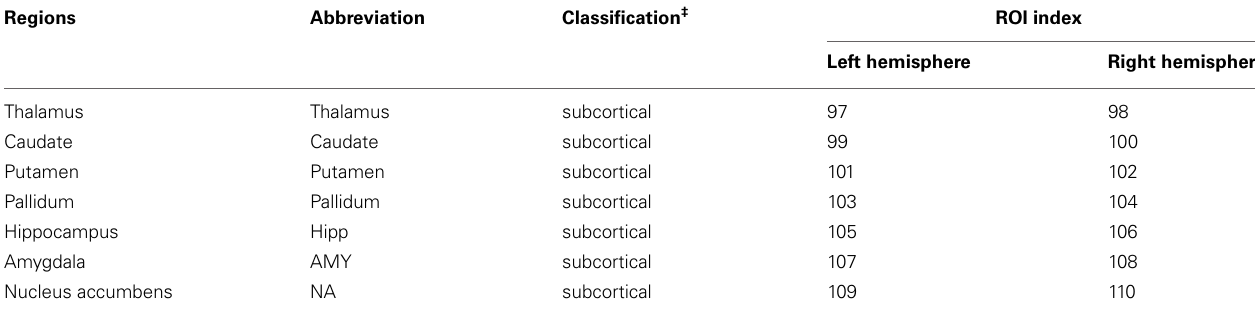
p -value = 0.018) and normalized global efficiency E glob (permutation-based p -value = 0.008) between experts and novices (panel C ). Error bars